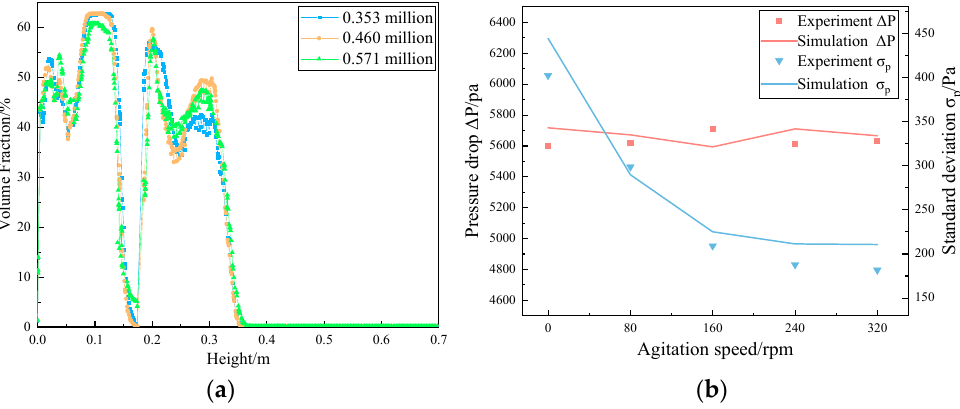
Figure 2. Grid independence verification and experimental verification. ( a ) Grid independence verification; ( b ) experimental verification.